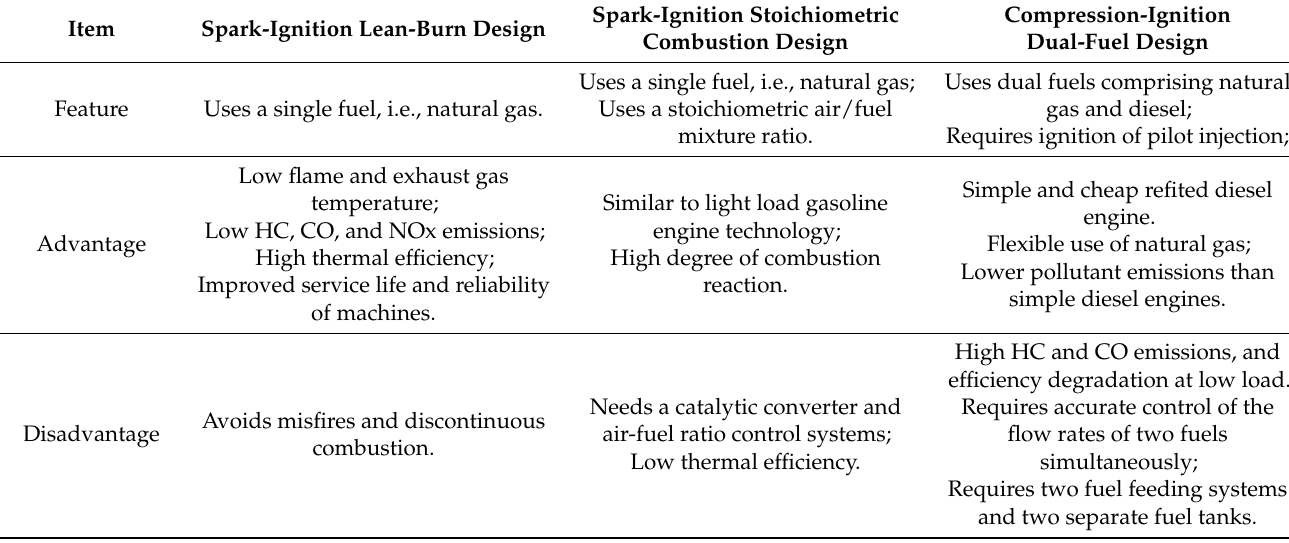
Table 3. Comparison of technical features, advantages and disadvantages of LNG engines. Spark-Ignition Lean-Burn Design